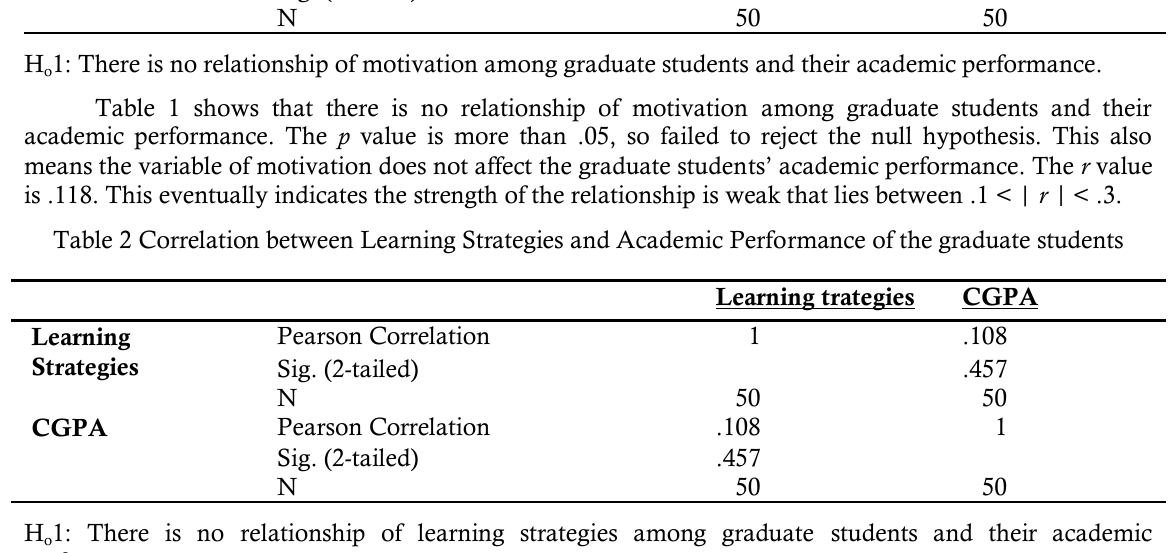
Table 2 Correlation between Learning Strategies and Academic Performance of the graduate students